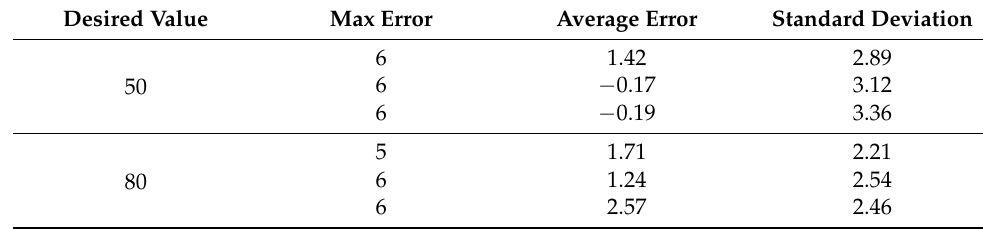
Figure 8. The pictures and curves of depth tracking. ( A ) The pictures of tracking a specified depth. ( B ) The curve of tracking a specified depth. ( C ) Comparison of the Mandani fuzzy algorithm and T-S fuzzy NN algorithm. ( D ) The desired depth switched from 70 cm to 30 cm. ( E ) The desired depth switched from 30 cm to 70 cm. ( F ) The curve of depth switched. ( G ) The curves of the depth tracking anti-interference experiments. Table 3. Error analysis of depth